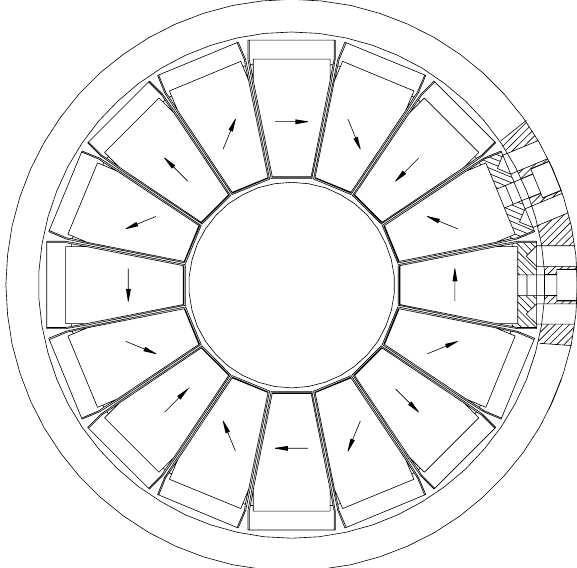
FIG. 1. Phase-III permanent magnet quadrupole cross section